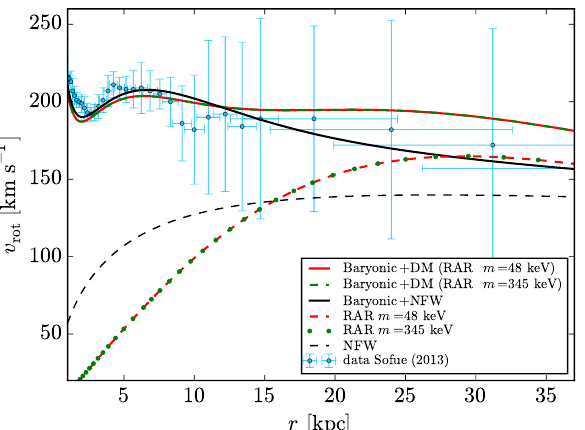
Figure 2. Magnification of the most relevant curves in the 1–35 kpc region and in the linear scale of the plot in the right panel of Figure 1. The graphic allows us to better appreciate the differences between the diverse DM models in the radial window where the rotation curve is most relevant. Reprinted from [32], Copyright (2018), with permission from